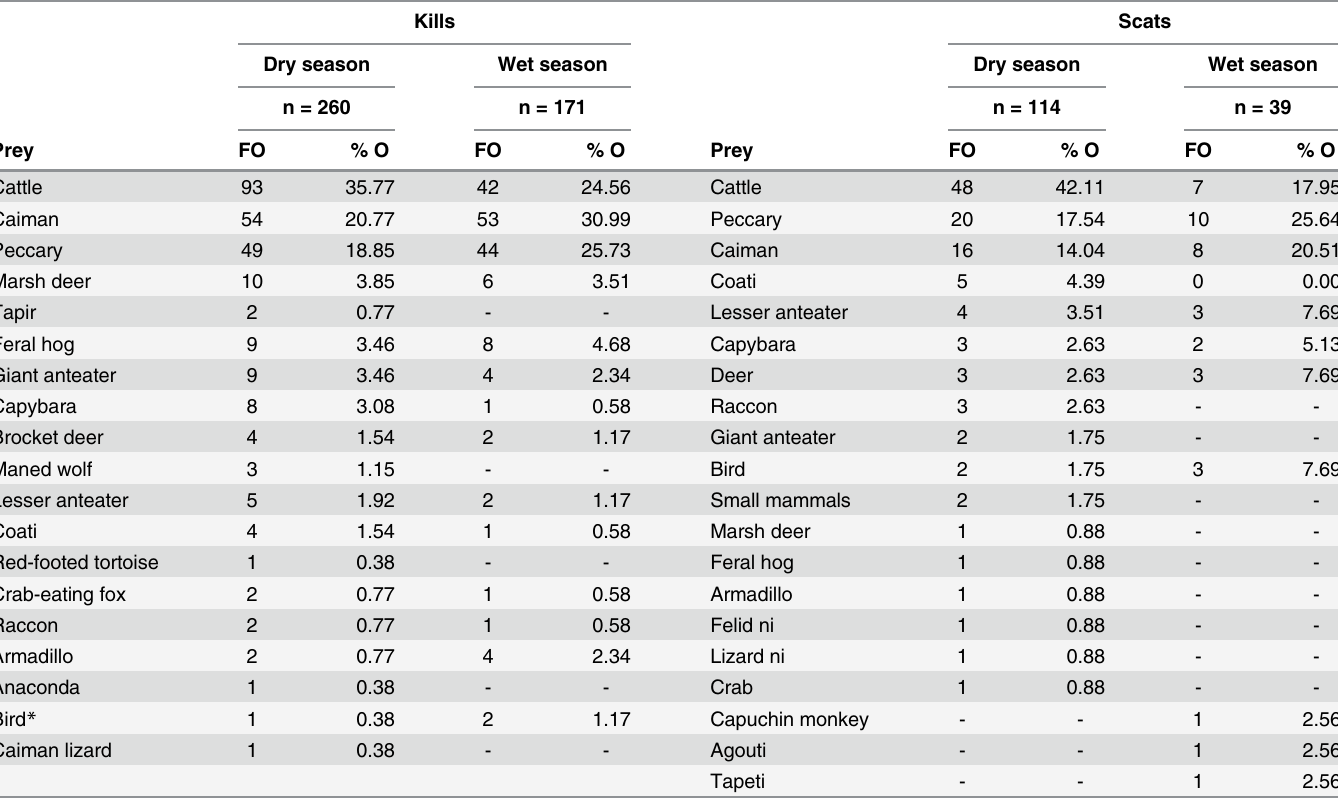
Table 2. Frequency of occurrence (FO) and relative frequency of occurrence (%O) of kills found on jaguars GPS location clusters, and prey remains found in 125 jaguar scats, during dry and wet seasons from 2001 to 2004, Southern Pantanal,